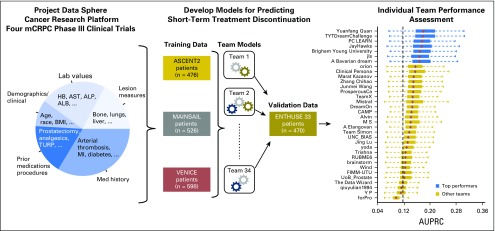
Study design. Data were acquired from Project Data Sphere Cancer Research Platform and centrally curated by the organizing team to create a standardized data set across the four studies. Three of the studies (ASCENT2, VENICE, and MAINSAIL) were selected as training sets, and a fourth data set (ENTHUSE 33) was withheld as a validation set. Teams submitted risk scores for evaluation in the validation set, which were scored and ranked by using the area under the precision-recall curve (AUPRC). The vertical dashed line in the rightmost panel represents the bootstrap estimate of the fraction of discontinuation events in the ENTHUSE33 dataset. (NOTE. Precision = positive predictive value, recall = sensitivity.) ALB, albumin; ALP, alkaline phosphatase; BMI, body mass index; HB, hemoglobin; mCRPC, metastatic castration-resistant prostate cancer; MI, myocardial infarction; TURP, transurethral resection of the prostate.